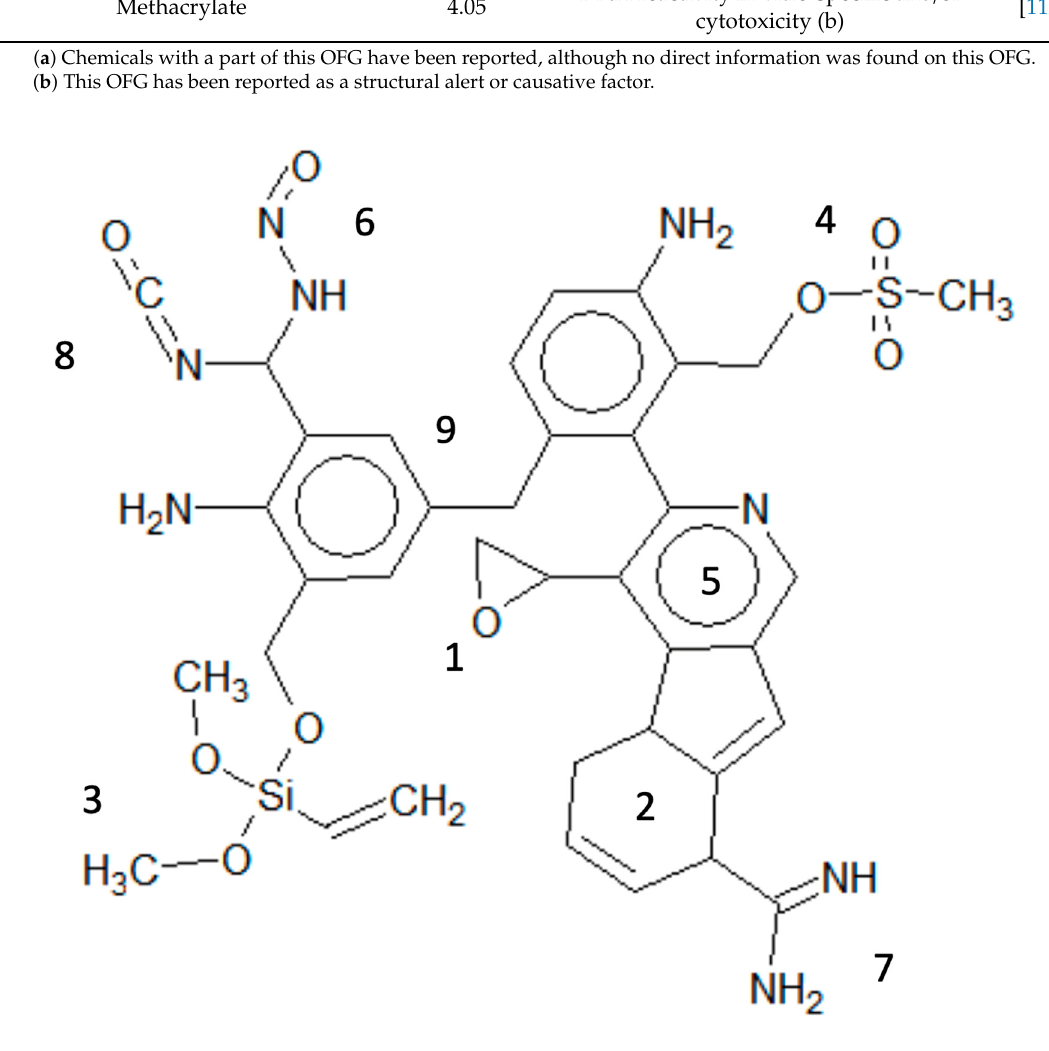
Figure 1. Virtual poly-clastogens derived from OFGs related to positives. Poly-clastogens were described on the basis of Table 2. The names of OFGs are as follows: (1) Epoxide, (2) Fused unsaturated carbocycles, (3) Alkoxysilane, (4) Sulfonate ester, (5) Fused heterocyclic aromatic, (6) N. Nitroso, (7) Amidine, (8) Isocyanate, and (9) Dianilines.